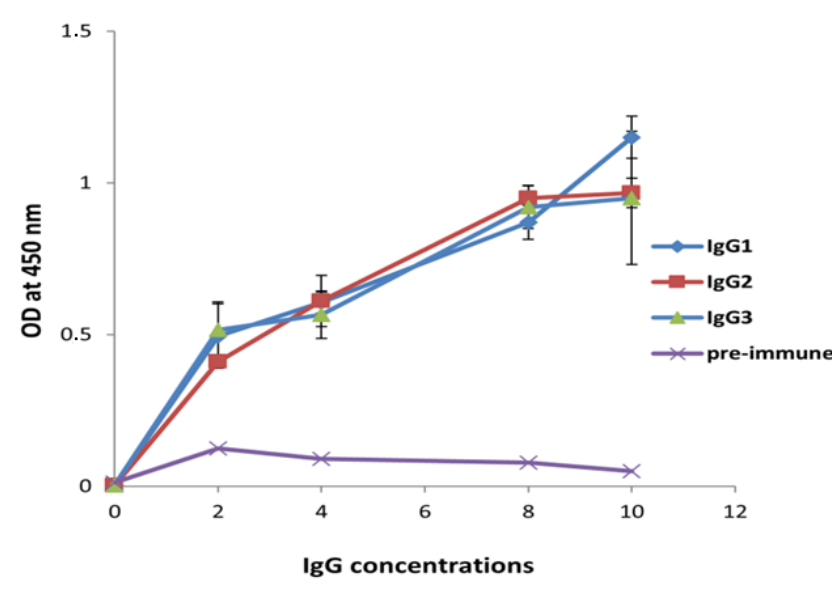
Figure 2. Reactivity of immunoglobulin G fractions was tested by ELISA using NDM ‐ 1 enzyme at a concentration of 1 μ g/mL and various concentrations of IgG subclasses ( μ g/mL). Preimmune serum was used as a negative control. The signal values were measured at 450 nm. Error bars represent standard deviation.